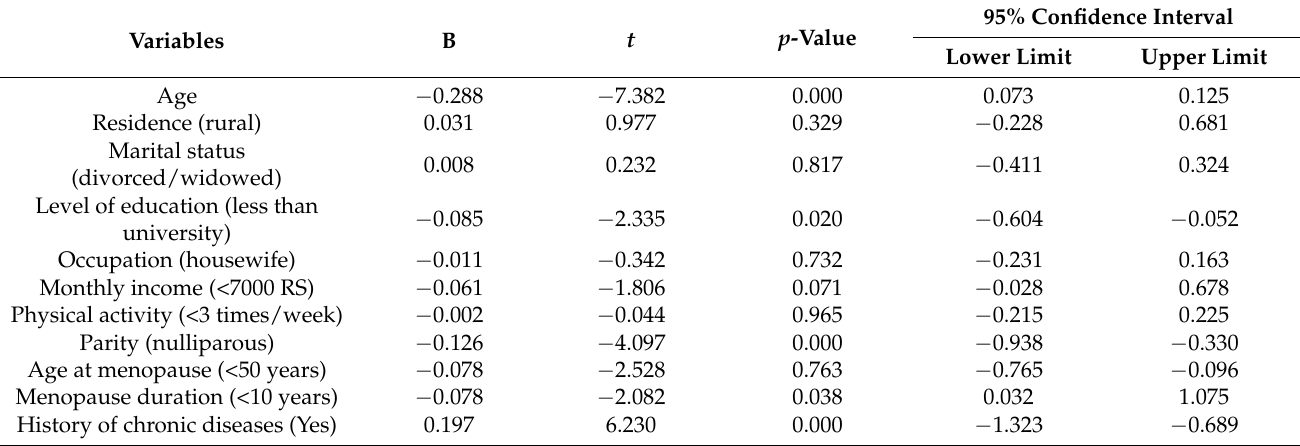
Table 6. Linear regression model showing the predictors of the urogenital domain in MRS score among Saudi women attending different primary health